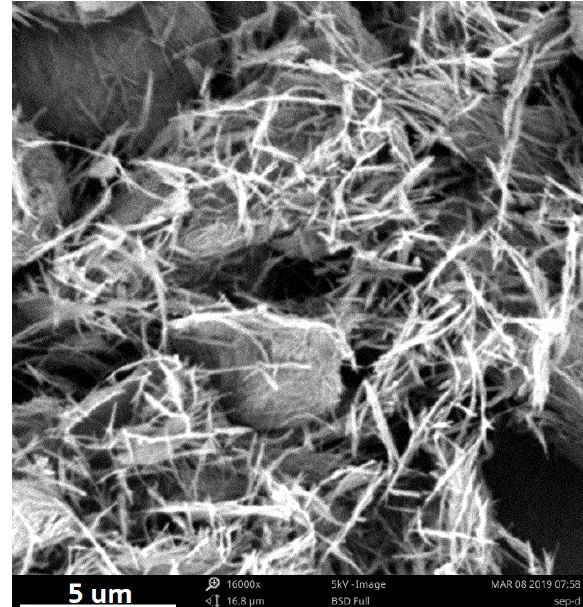
Figure 1. SEM image of metakaolin. Figure 2. SEM image of